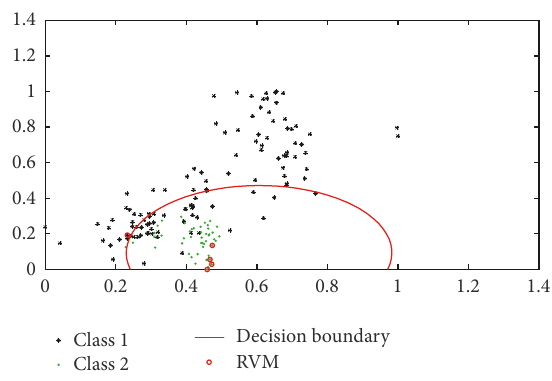
Figure 7: Classification of sample data by